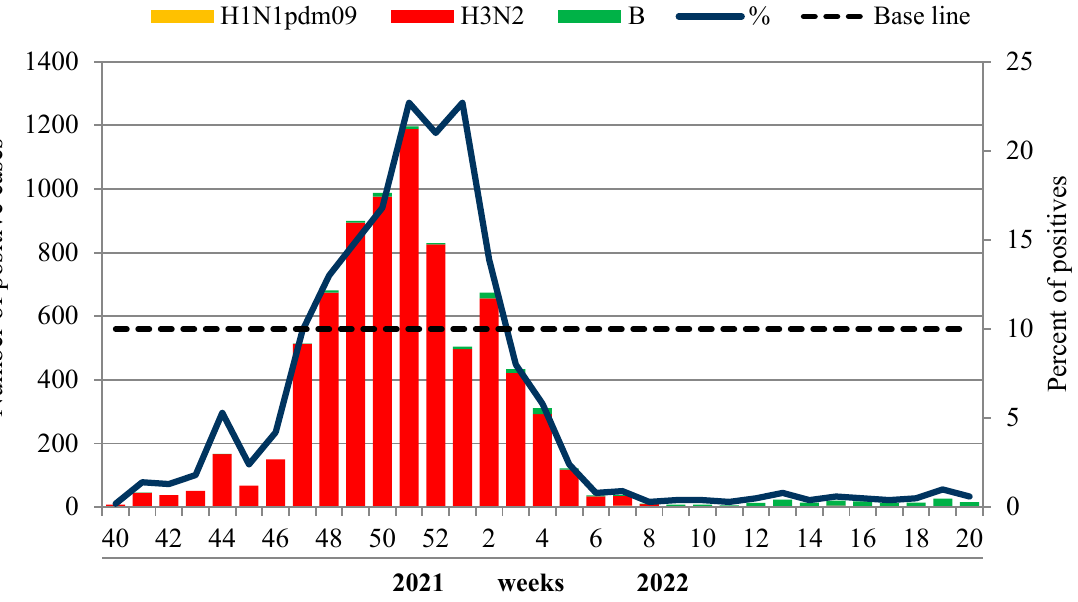
Figure 5. PCR-monitoring of influenza A(H3N2) and B virus circulation, season Figure 5. PCR ‐ monitoring of influenza A(H3N2) and B virus circulation, season 2021–2022.